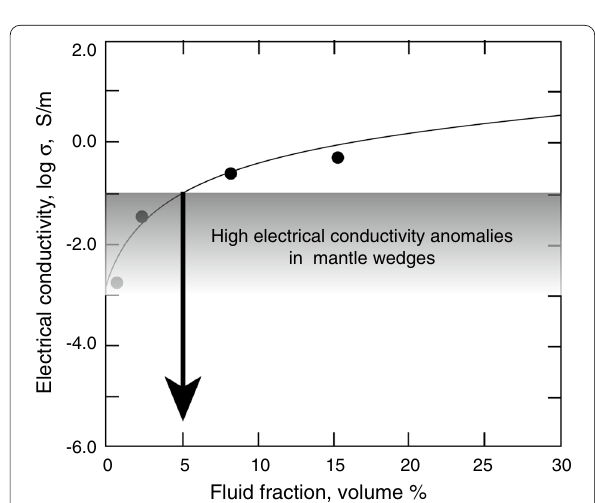
Fig. 42 Electrical conductivity of forsterite fluid volume. Also shown is a range of conductivity anomalies in mantle wedges above subducting plates. Modified from Huang et al.